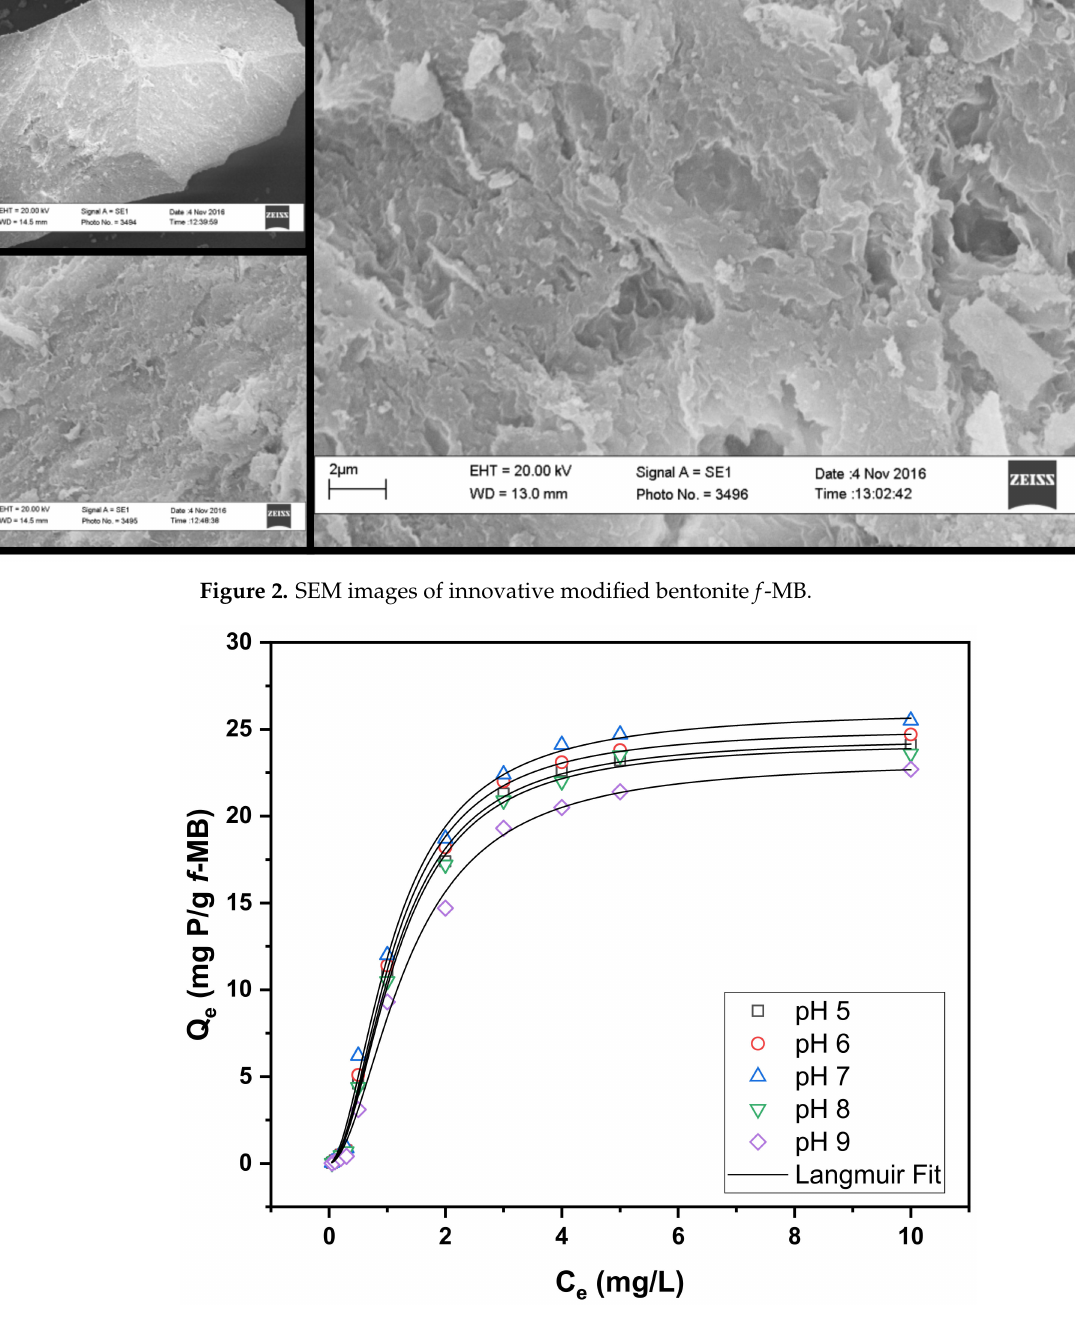
Figure 3. Experimental and calculated (Langmuir model) isotherms fitting of phosphate uptake by f -MB at different pH values. Phosphate concentration 0.05–10 mg/L, adsorbent dose 0.2 g, aqueous solution: synthetic wastewater